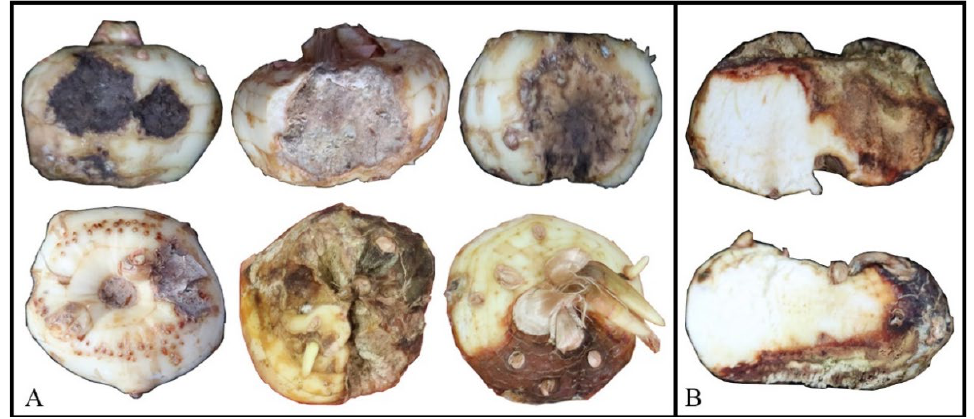
Figure 1. ( A ) Typical field symptom of Fusarium corm rot on saffron in China. ( B ) Longitudinal section of corms exhibiting rot developing into endosperm. section of corms exhibiting rot developing into